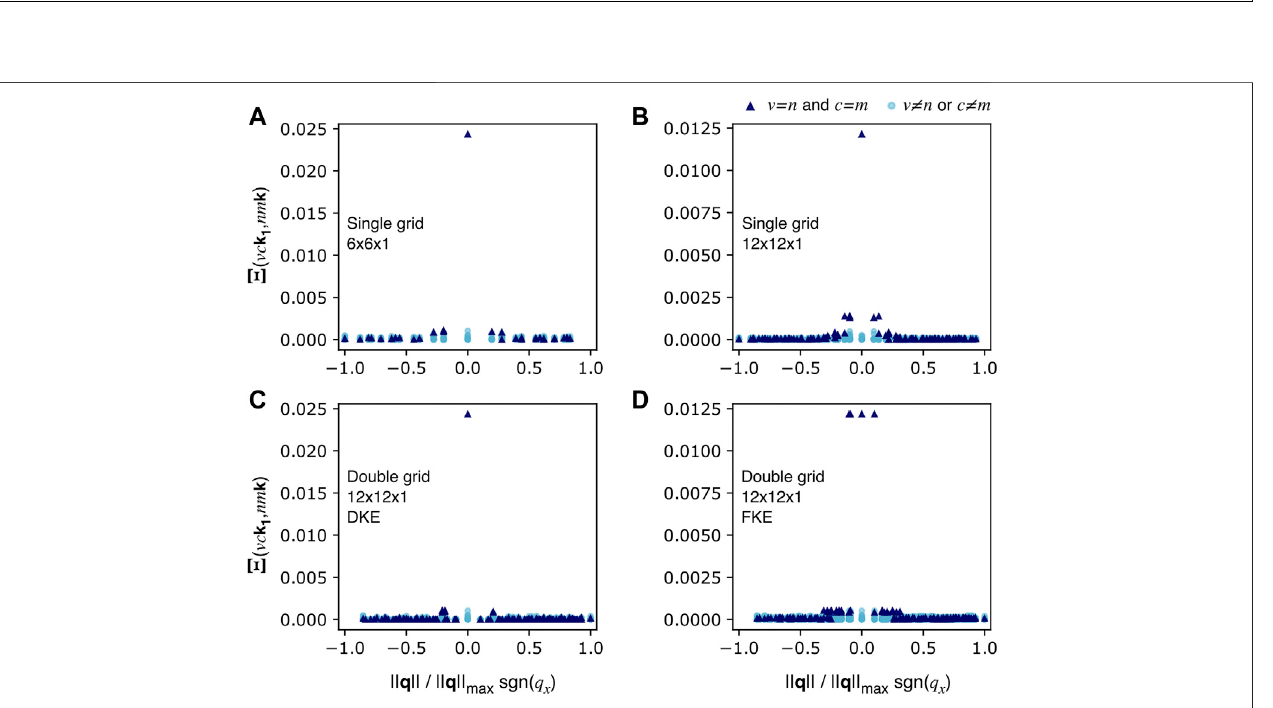
Frontiers in Chemistry |